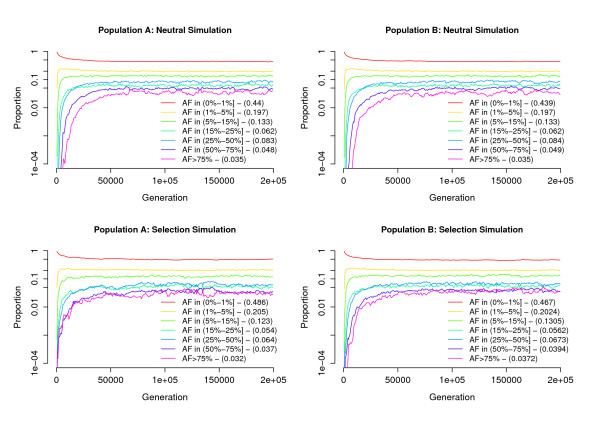
Evolution of the distribution of allele frequencies. Populations A (left) and B (right), simulated without (top) and with (bottom) selection. The mean proportion of sites within each allele frequency range, averaged over the final 100 k generations, is shown in parentheses.